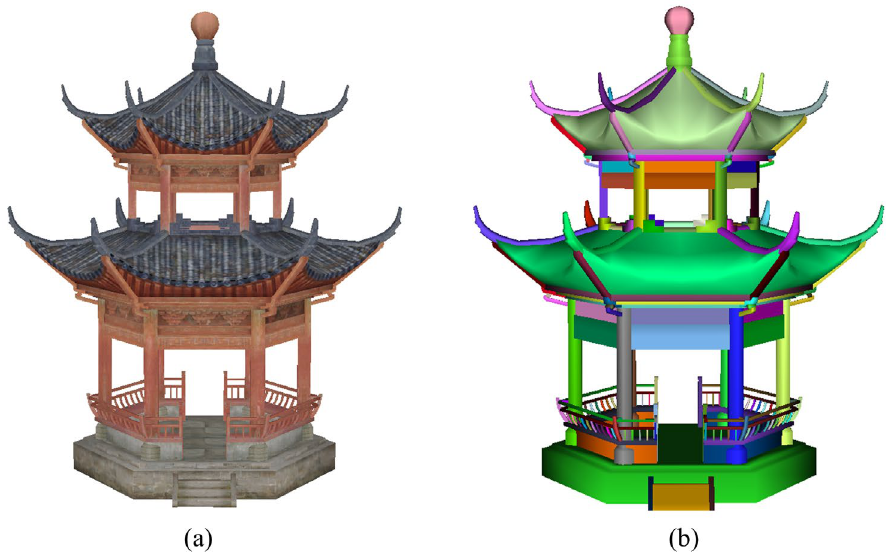
Figure 4. Component segmentation of the building model: ( a ) the original model; ( b ) the result (different colors represent different components).